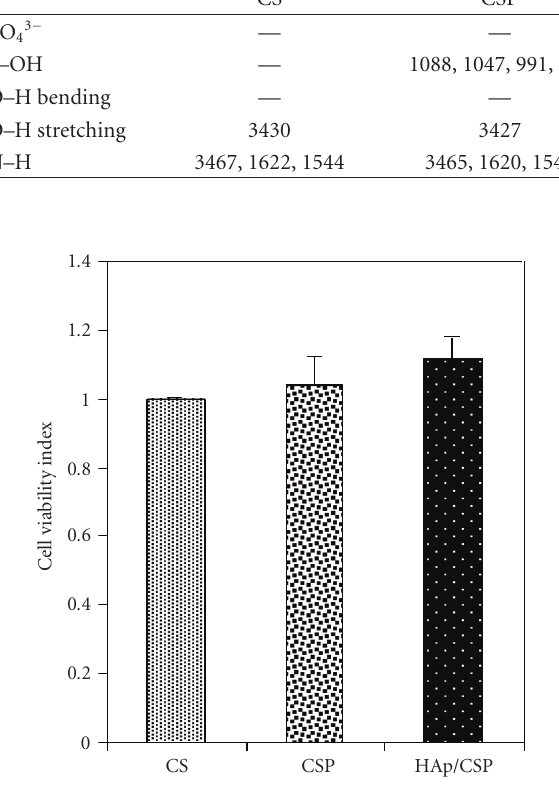
Table 1: FTIR peak positions of various functional groups before and after composite formation. Functional groups